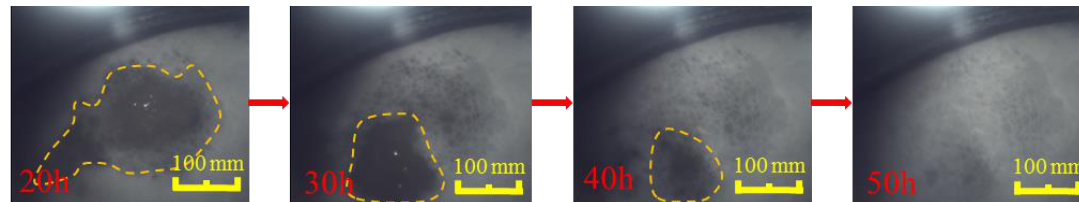
Figure 10. Preparation process of natural gas hydrate by bubbling method. The yellow dotted line indicates the hydrate boundary. ( a )In the first panel, The white flocculent is hydrate. The area of darker color in contact with hydrate is the prepared water. ( b )In the second panel, The white flocculent is hydrate. The area of darker color in contact with hydrate is the prepared water. ( c )In the third panel, The white flocculent is hydrate. The area of darker color in contact with hydrate is the prepared water. ( d )In the fourth panel, The white flocculent is hydrate.